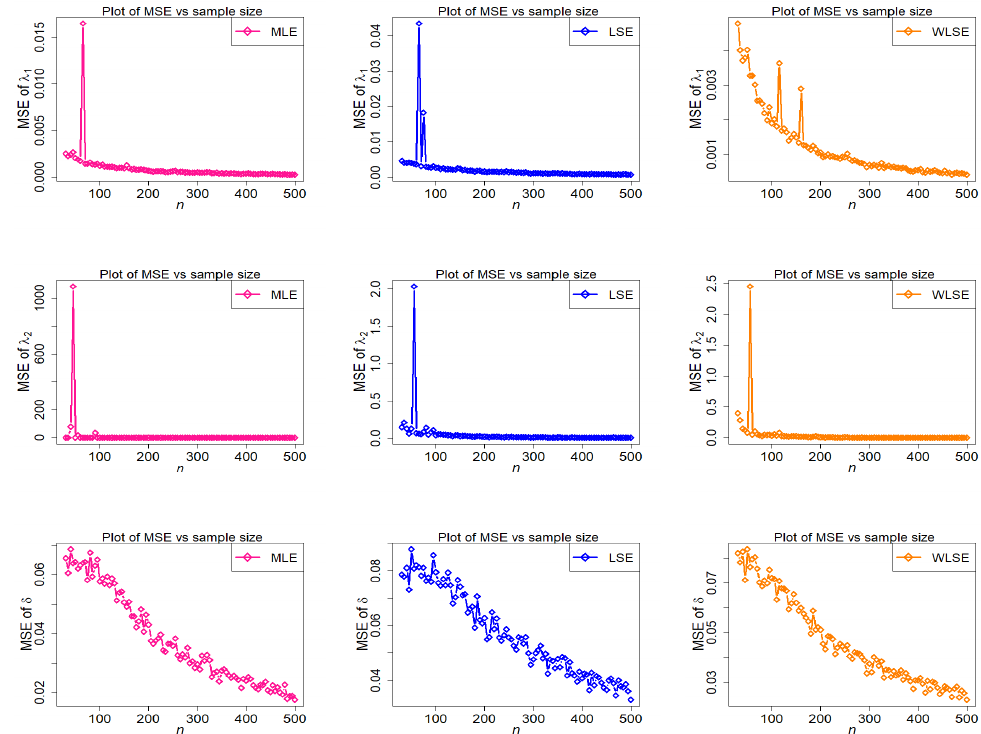
Fig. 10. Behaviour of MSE of estimators with di⁄erent methods under parametric set I Figure 10. Behavior of MSE of estimators with different methods under parametric set I against n . against n .